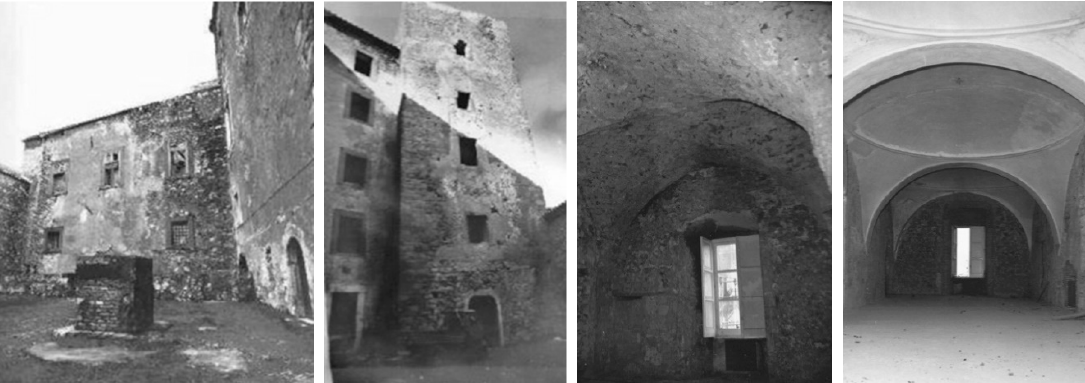
Figure 12. Historical photos of the Castle of Melfi (PZ) in the second half of the 1970s (from MiBACT Archives).